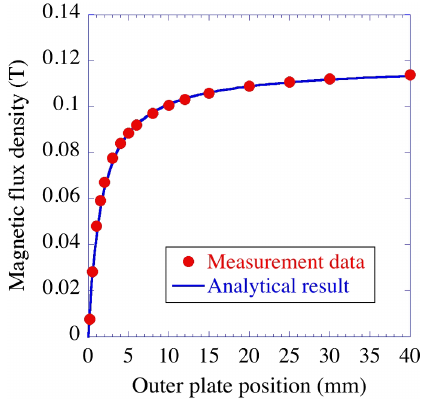
FIG. 3. Measured data (red circles) and analytical result (blue line) of magnetic flux density as a function of the outer plate position. See the Appendix for the analytical